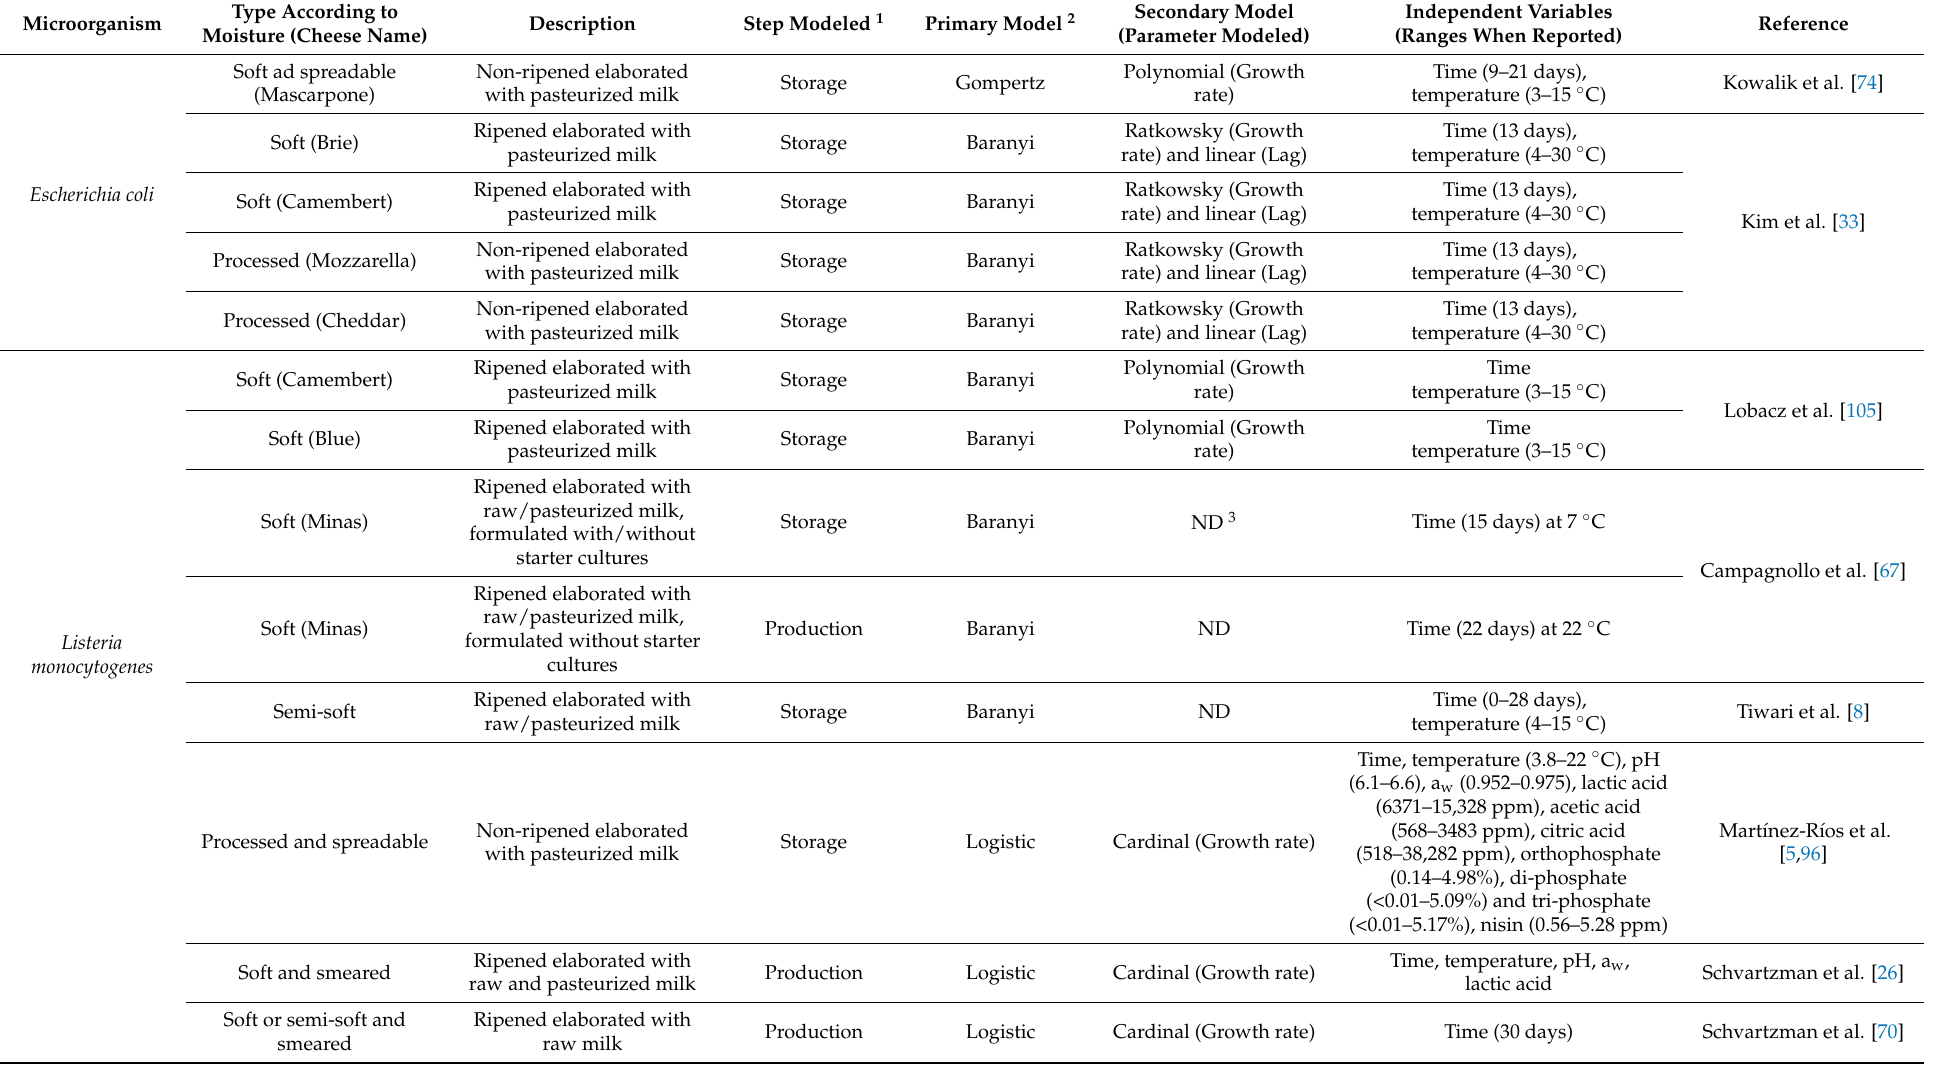
Table 1. Microbial primary and secondary growth models developed in